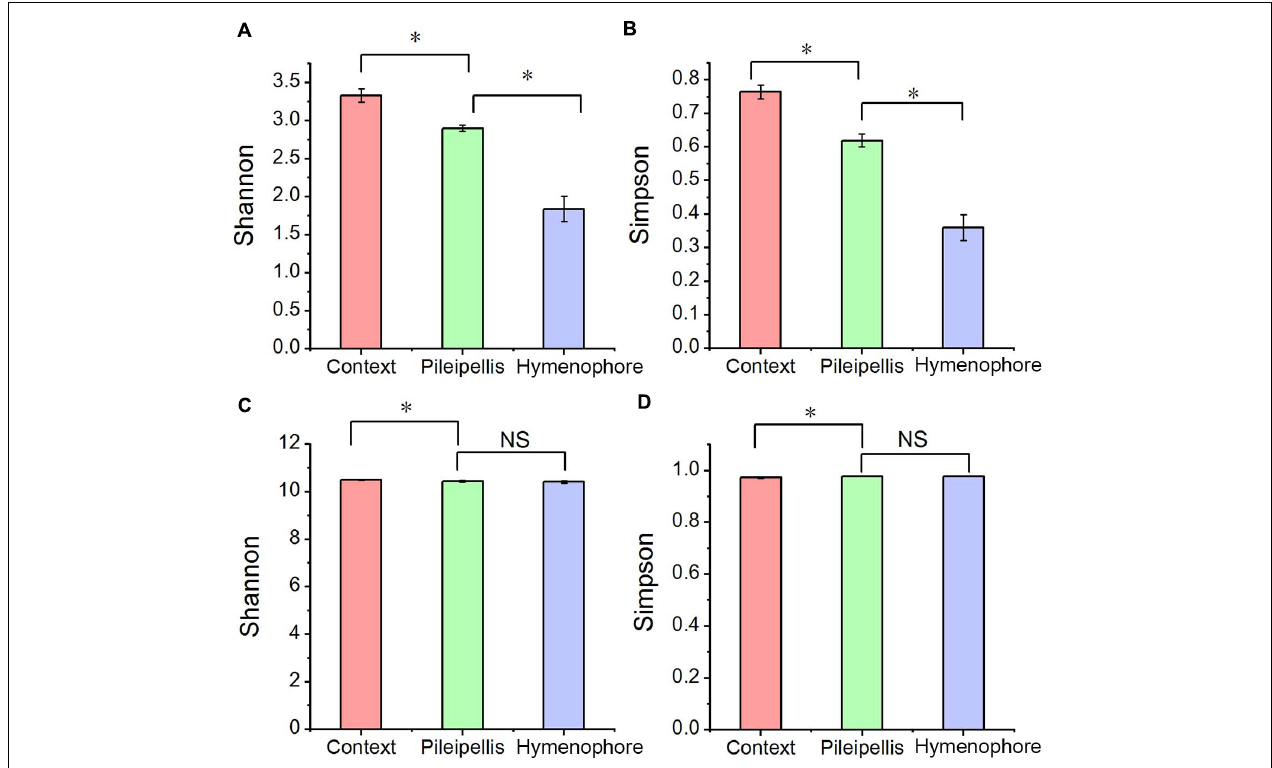
FIGURE 2 | The alpha diversity changes in Thelephora ganbajun bacterial communities (A,B) and functional genes (C,D) in three tissue compartments. For individual figures, significant differences between compartments are indicated with an asterisk (Tukey HSD, P < 0.05) and NS is not significant ( P > 0.05).